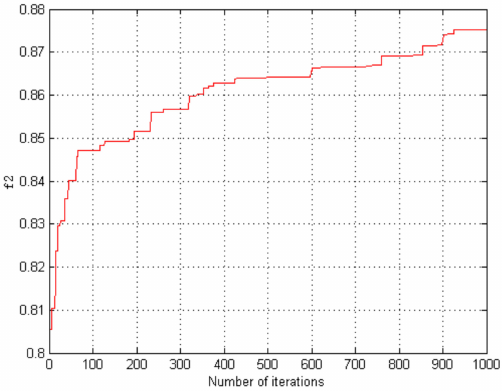
Figure 9. Curve of objective function 1.